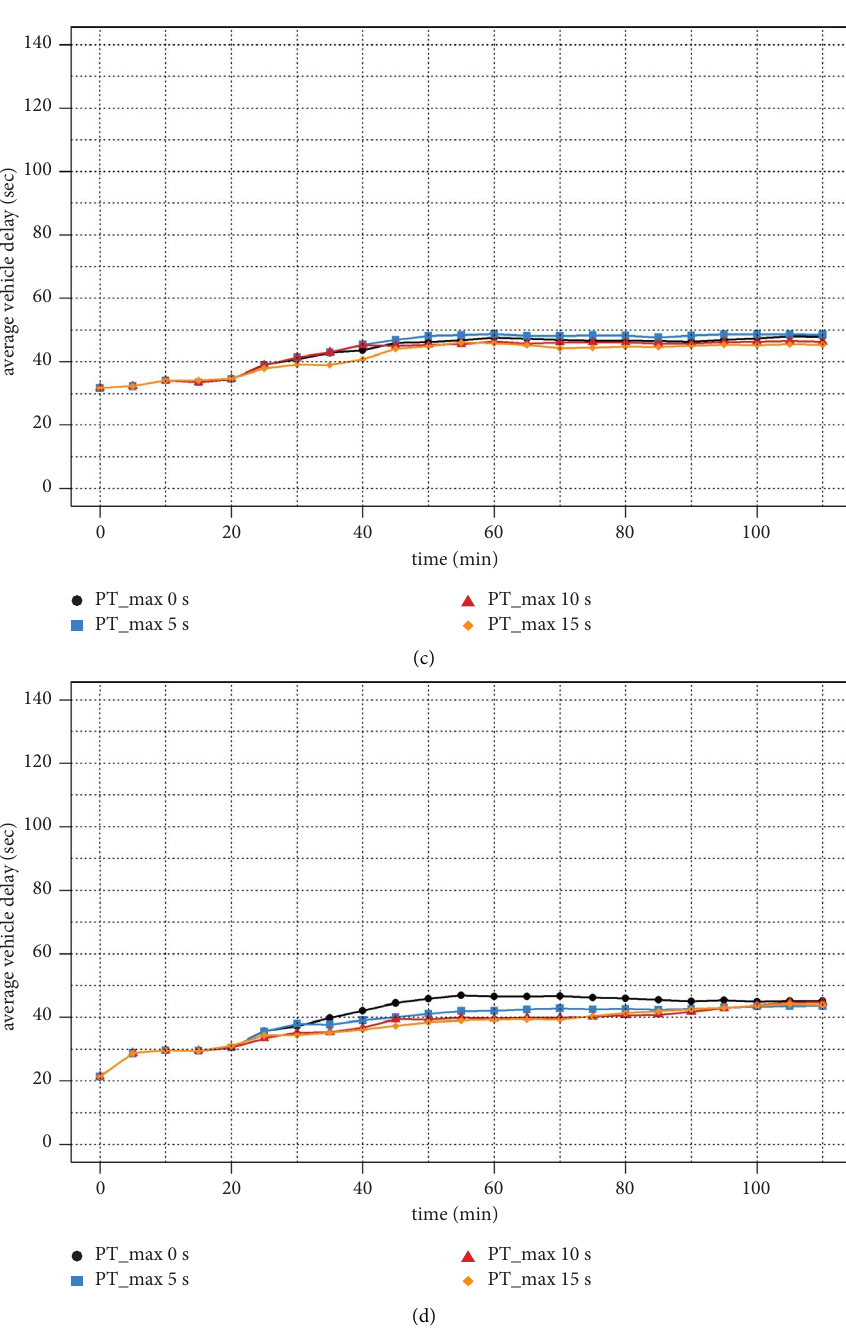
Figure 9: Vehicle delay of general roads based on BRT signal priority. (a) MPR 25%, (b) MPR 50%, (c) MPR 75%, and (d) MPR